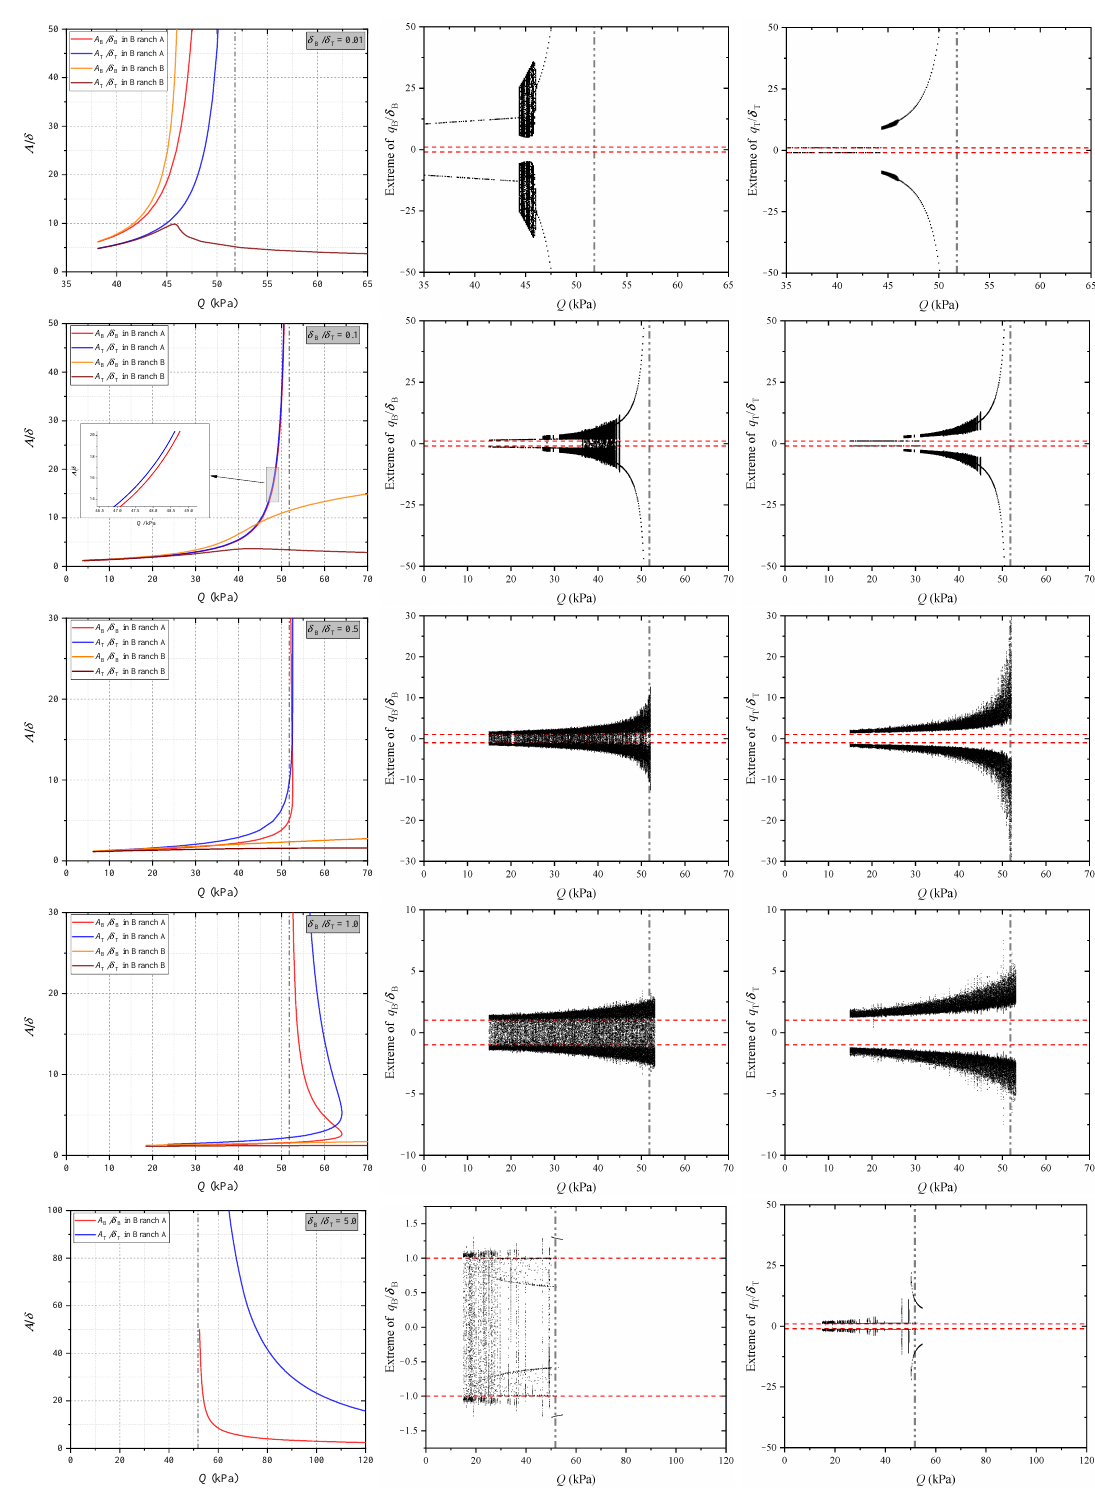
Figure 10. Frequency-domain LCO solutions and corresponding time-domain bifurcation diagrams in bending and torsional DOFs ( δ B / δ T is 0.01, 0.1, 0.5, 1.0, and 5.0 from top to bottom). From the frequency-domain calculation results, we can find that there are two main LCO branches for each δ B / δ T . Combined with the time-domain results, it can be found that when the freeplay size ratio is small, stable LCO motions appear below the linear flutter dynamic pressure. In addition, irregular motions with limited amplitude are observed in